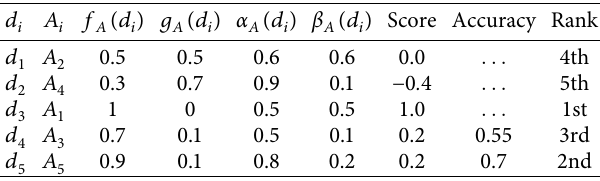
Table 10: LDFNs A i s along with scores, accuracies and rankings on ( B , ⊞ ) .